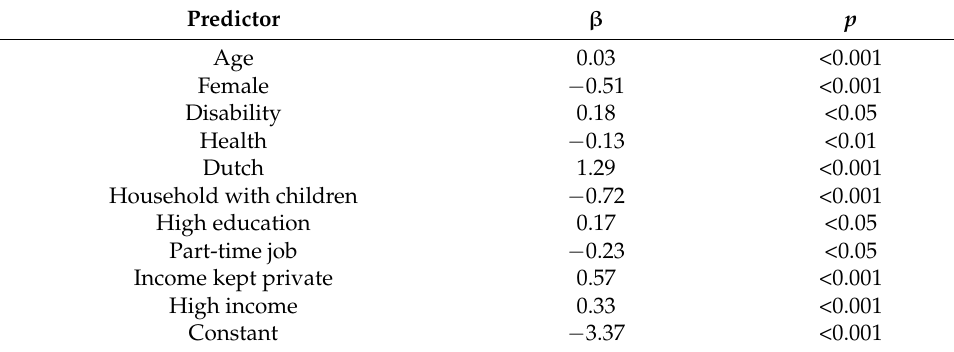
Table 5. Logistic regression predicting probability of belonging to class 1 (Nature-loving class) based on personal